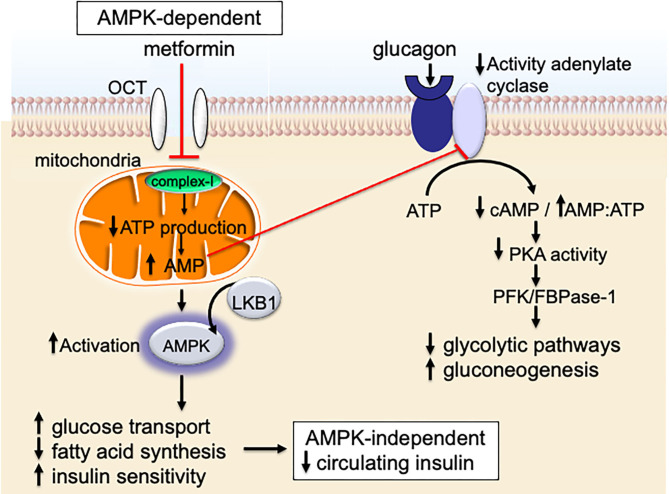
Metformin signaling in the liver.